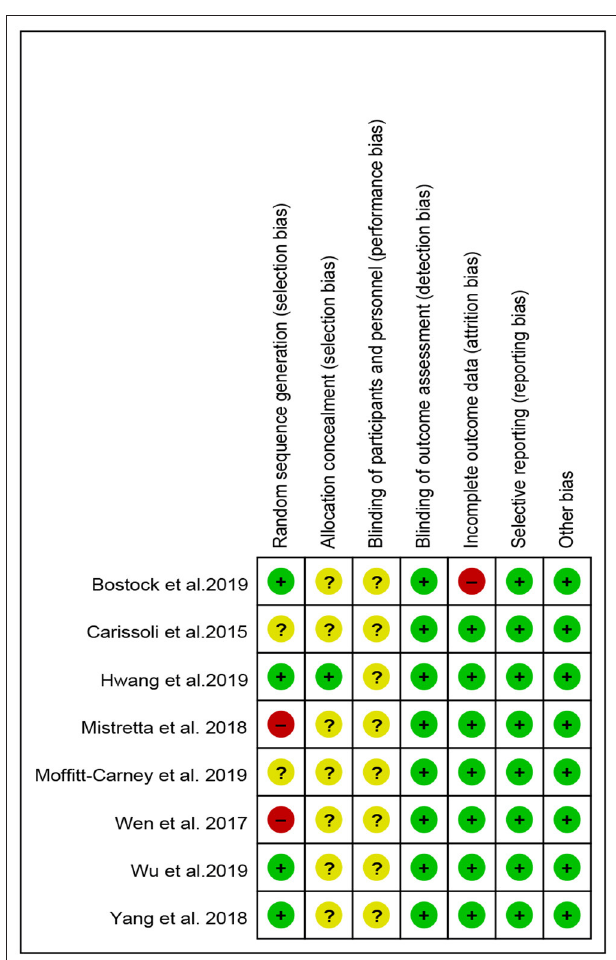
FIGURE 3 | Risk of bias of included studies. Green: low risk of bias; yellow: unclear risk of bias; red: high risk of bias.